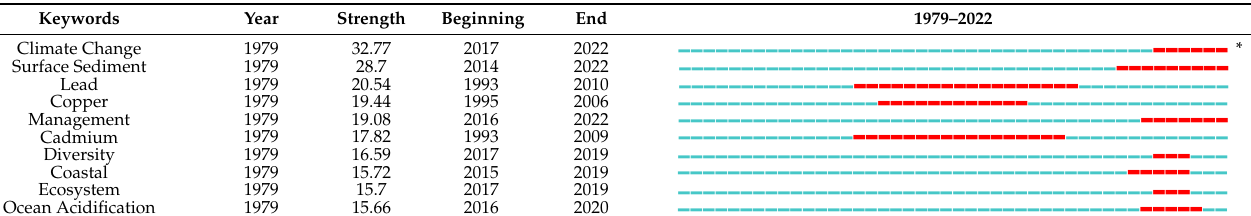
Coastal Ecosystem Ocean Acidification